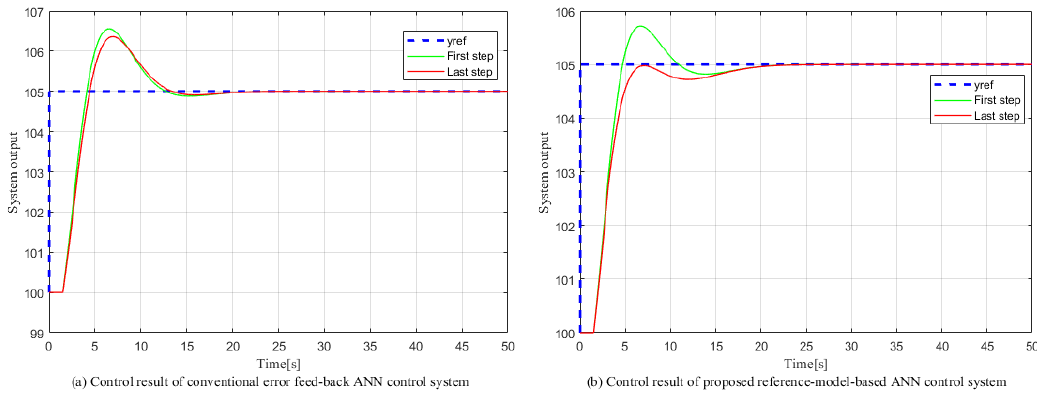
Figure 5. Comparison simulation results. ( a ) Time response of the conventional error feed back ANN control method and ( b ) Time response of the proposed reference-model-based ANN control method.